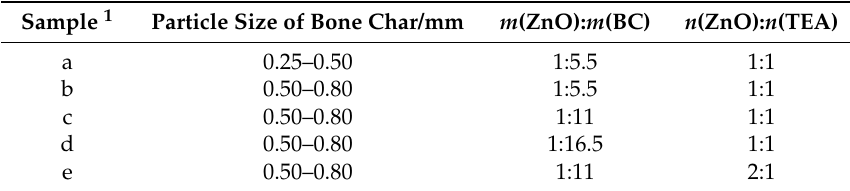
Table 1. ZnO/bone char (BC) samples obtained by different synthesis parameters. Sample